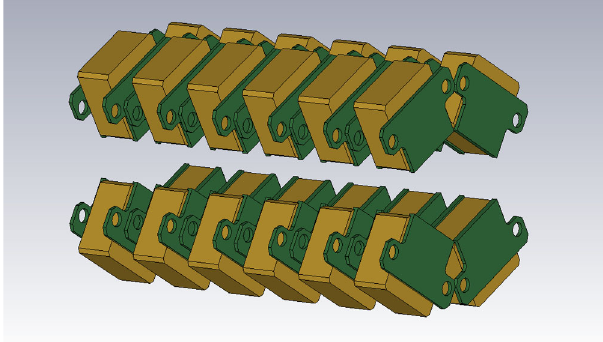
FIG. 2. Undulator geometry used in 3D simulations. Yellow blocks: permanent magnets; green plates: iron poles.